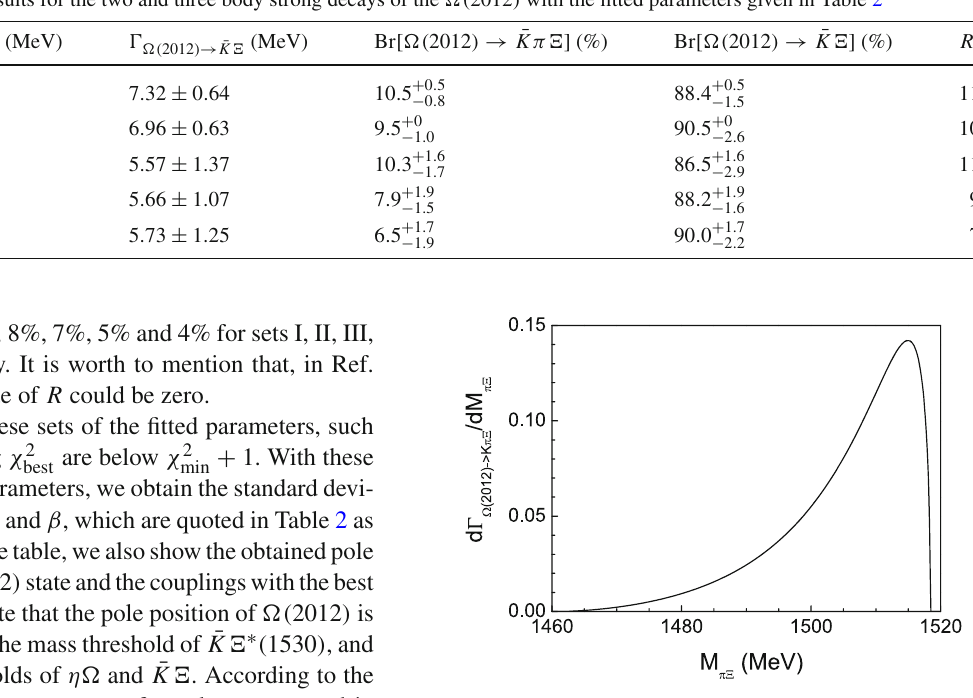
decay mechanisms of (cid:2)( 2012 ) are small, such as those of the triangle mechanisms of Refs.